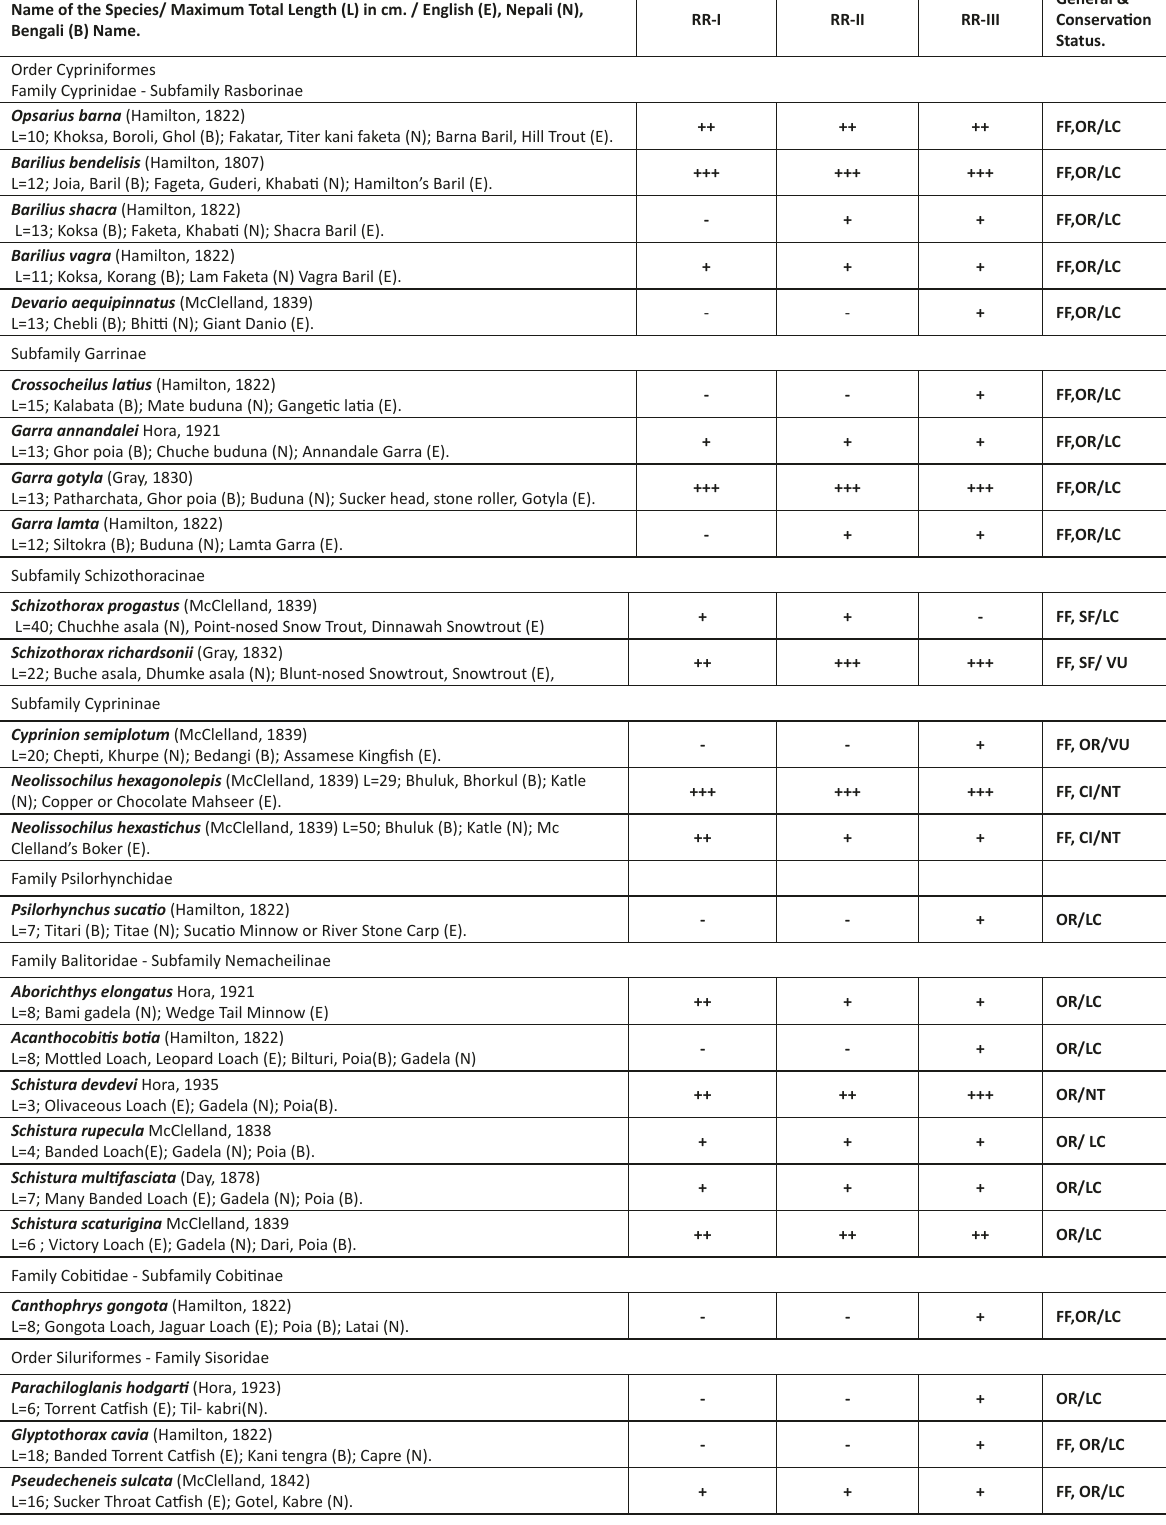
FF,OR/LC OR/LC + FF, OR/LC + + + FF, OR/LC